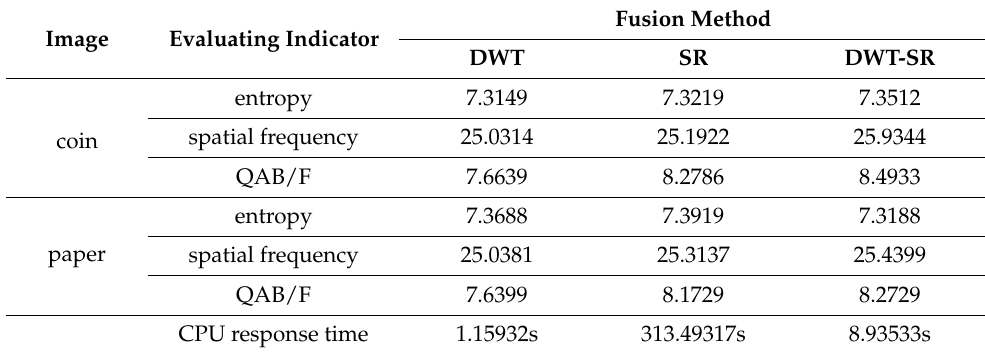
Table 2. Objective evaluation index of different fusion